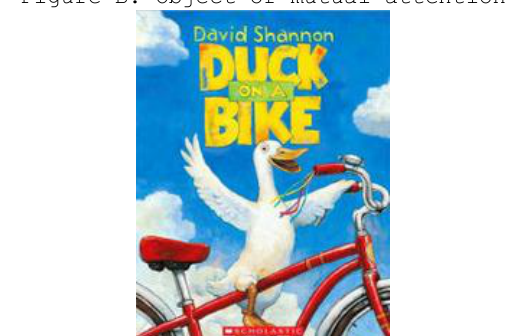
Figure B: Object of mutual